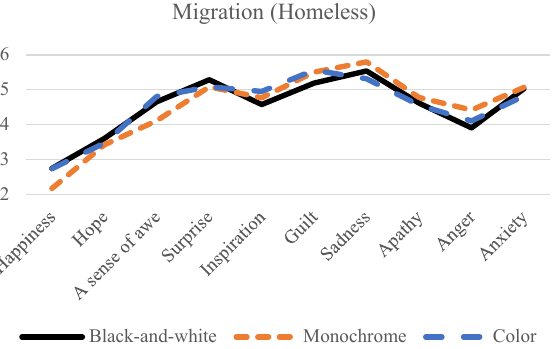
Figure 8. The line graph shows the average emotions of different colors in #3 image.